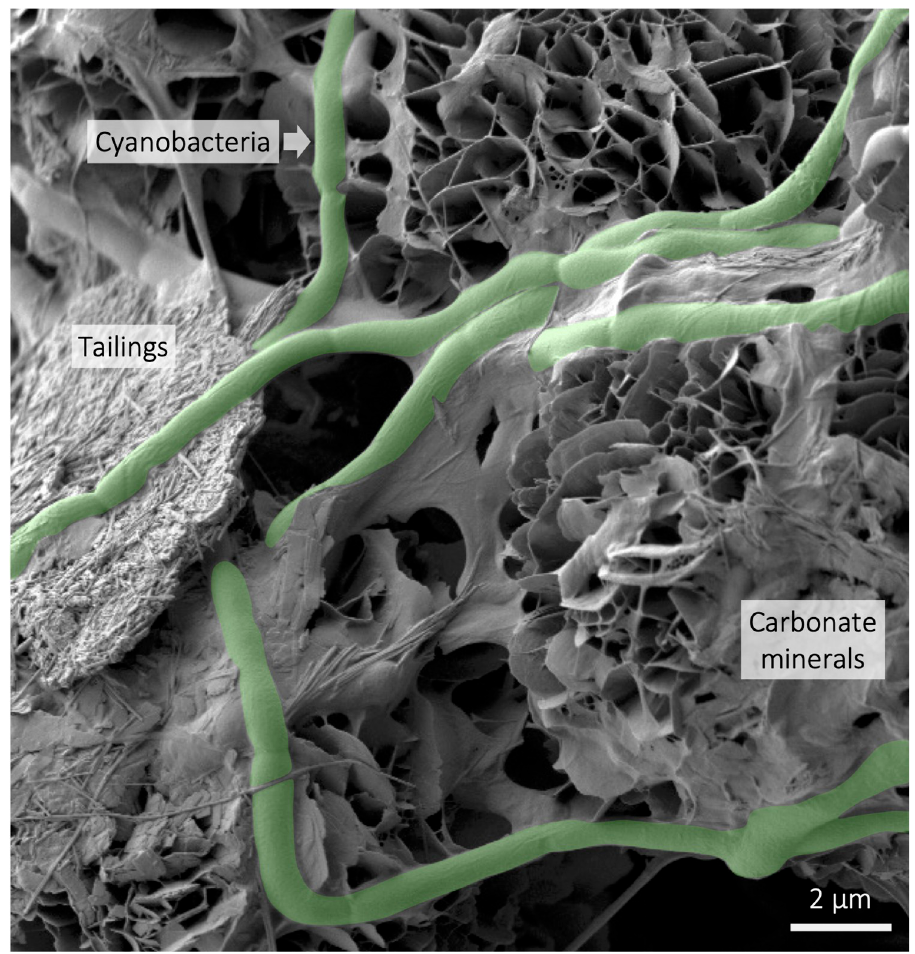
Fig 1. Cyanobacteria (green) precipitating carbonate minerals using tailing mineral weathering by-products